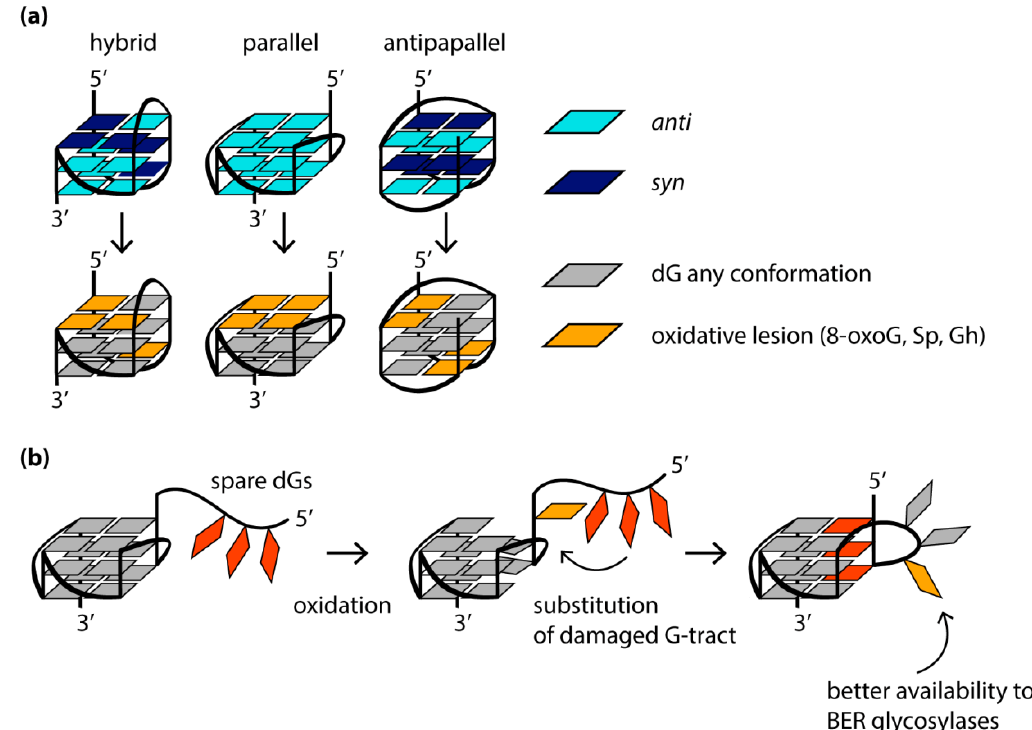
Figure 4. ( a ) Positions in G4s of different topologies that are most susceptible to oxidative damage. ( b ) Replacement of damaged guanine in the G4 core with available dG in loops or spare G-tracts helps to maintain the G4 structure and increases the accessibility of damaged dG residues for repair proteins.